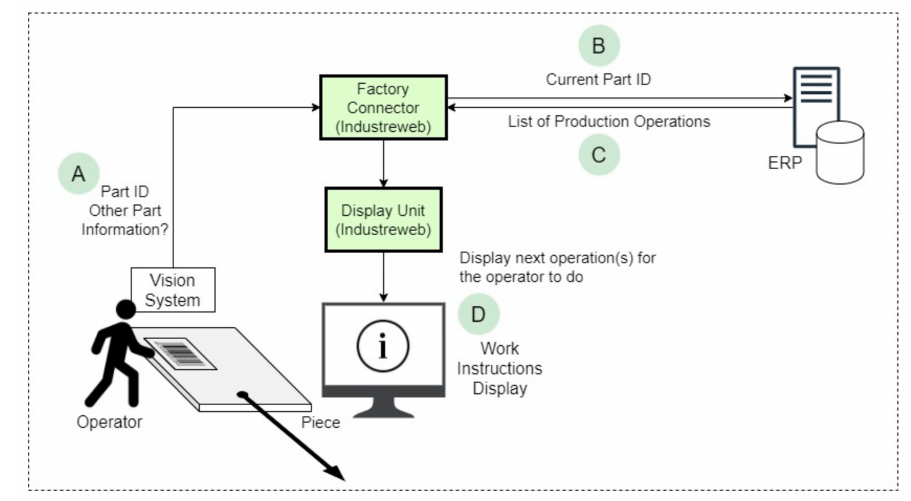
Figure 7. Data flow within Vision System solution.